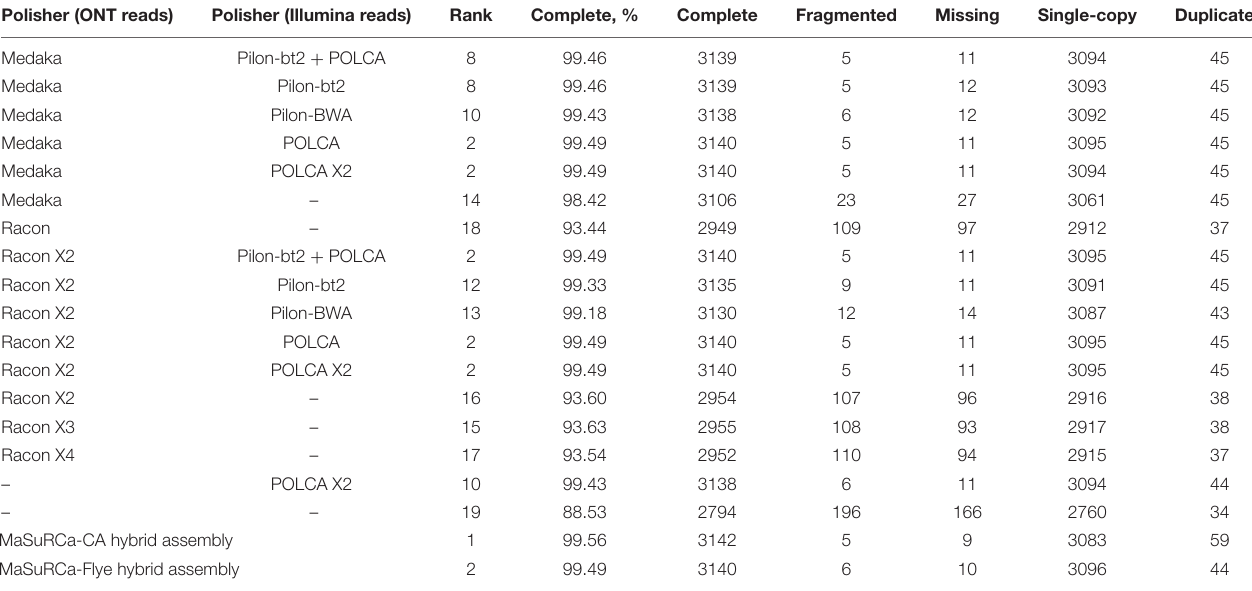
TABLE 2 | Results of BUSCO analysis for various combinations of Nanopore and/or Illumina polishers. Polisher (ONT reads) Polisher (Illumina reads) Rank Complete, % Complete Fragmented Missing Single-copy Duplicated